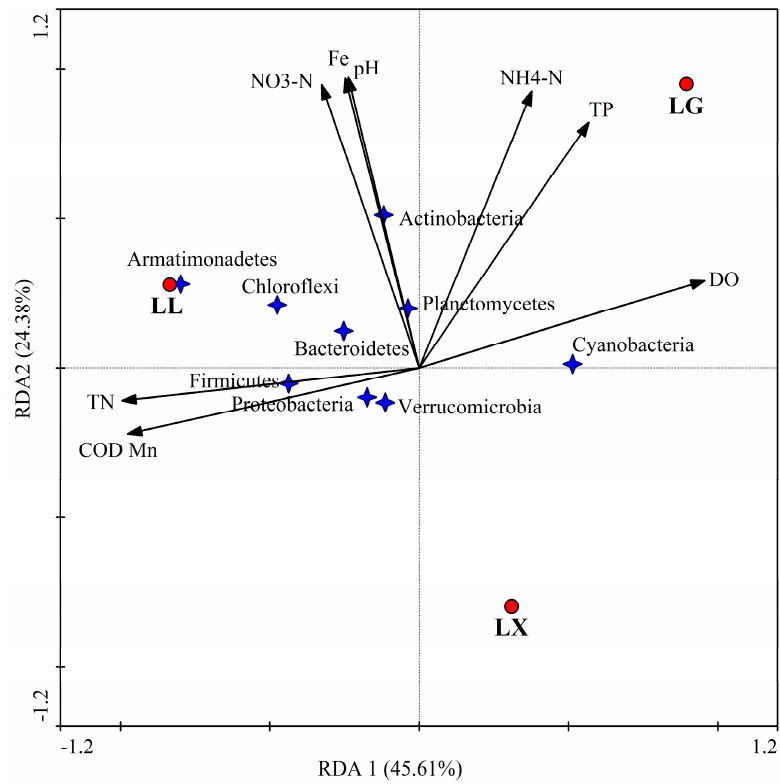
Figure 7. Redundancy analysis (RDA) of water bacterial communities in LX, LG and LL. RDA1 explained 45.61% and RDA2 explained 24.38% of the total variance. LX, LG and LL represent Xingqing lake, Geming lake and Lianhu lake, respectively. Water quality was found to be significantly correlated with bacterial community structure.